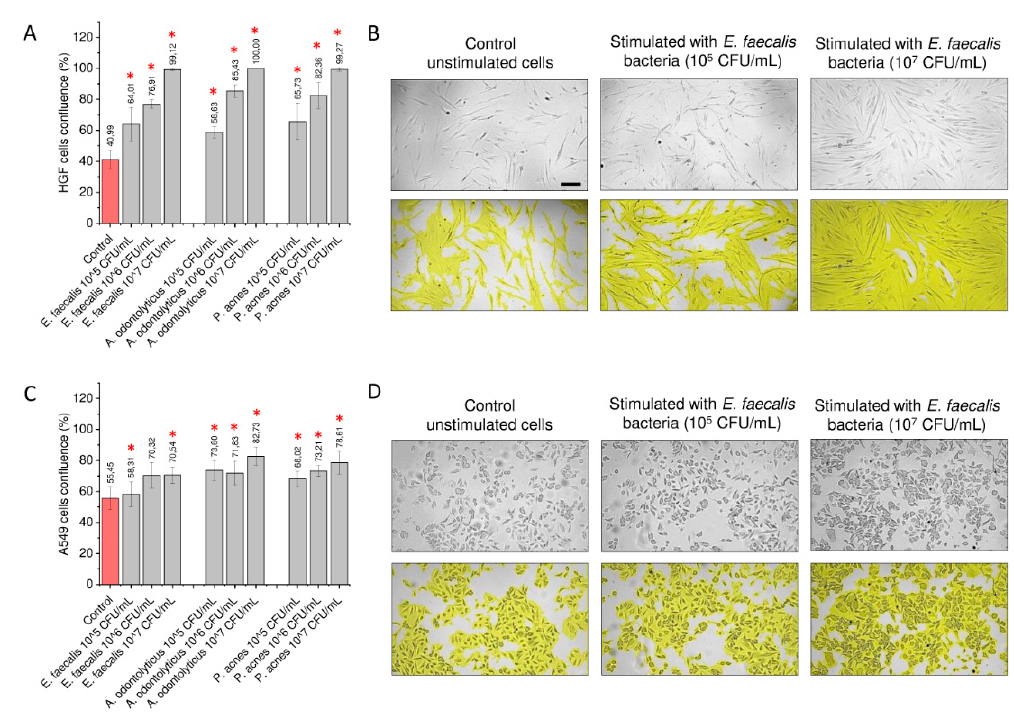
Figure 5. Alterations in morphological features and confluence of gingival and lung cancer cells upon stimulation with heat-inactivated bacteria. Increase of cellular confluence of HGF gingival (panel A ) and lung carcinoma A549 (panel C ) cells upon stimulation with heat-inactivated E. faecalis ATCC 29212, A. odontolyticus ATCC 17929, and P. acnes ATCC 11827 for 24 h. Representative microphotographs of HGF (panel B ) and A549 cells (panel D ) stimulated with varied concentrations of E. faecalis ATCC 29212 for 24 h. * indicates statistical significance ( p < 0.05) compared to unstimulated control cells. Scale bar ~10 µm.